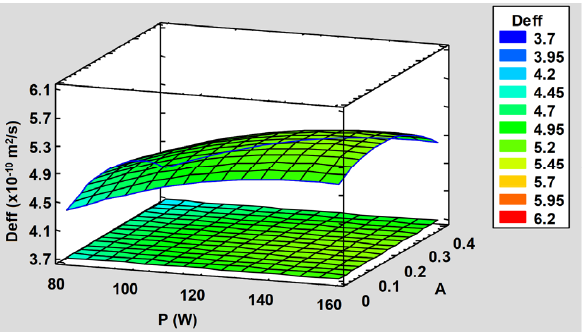
Figure 16. Effect of P and A on moisture diffusion coefficient Deff.